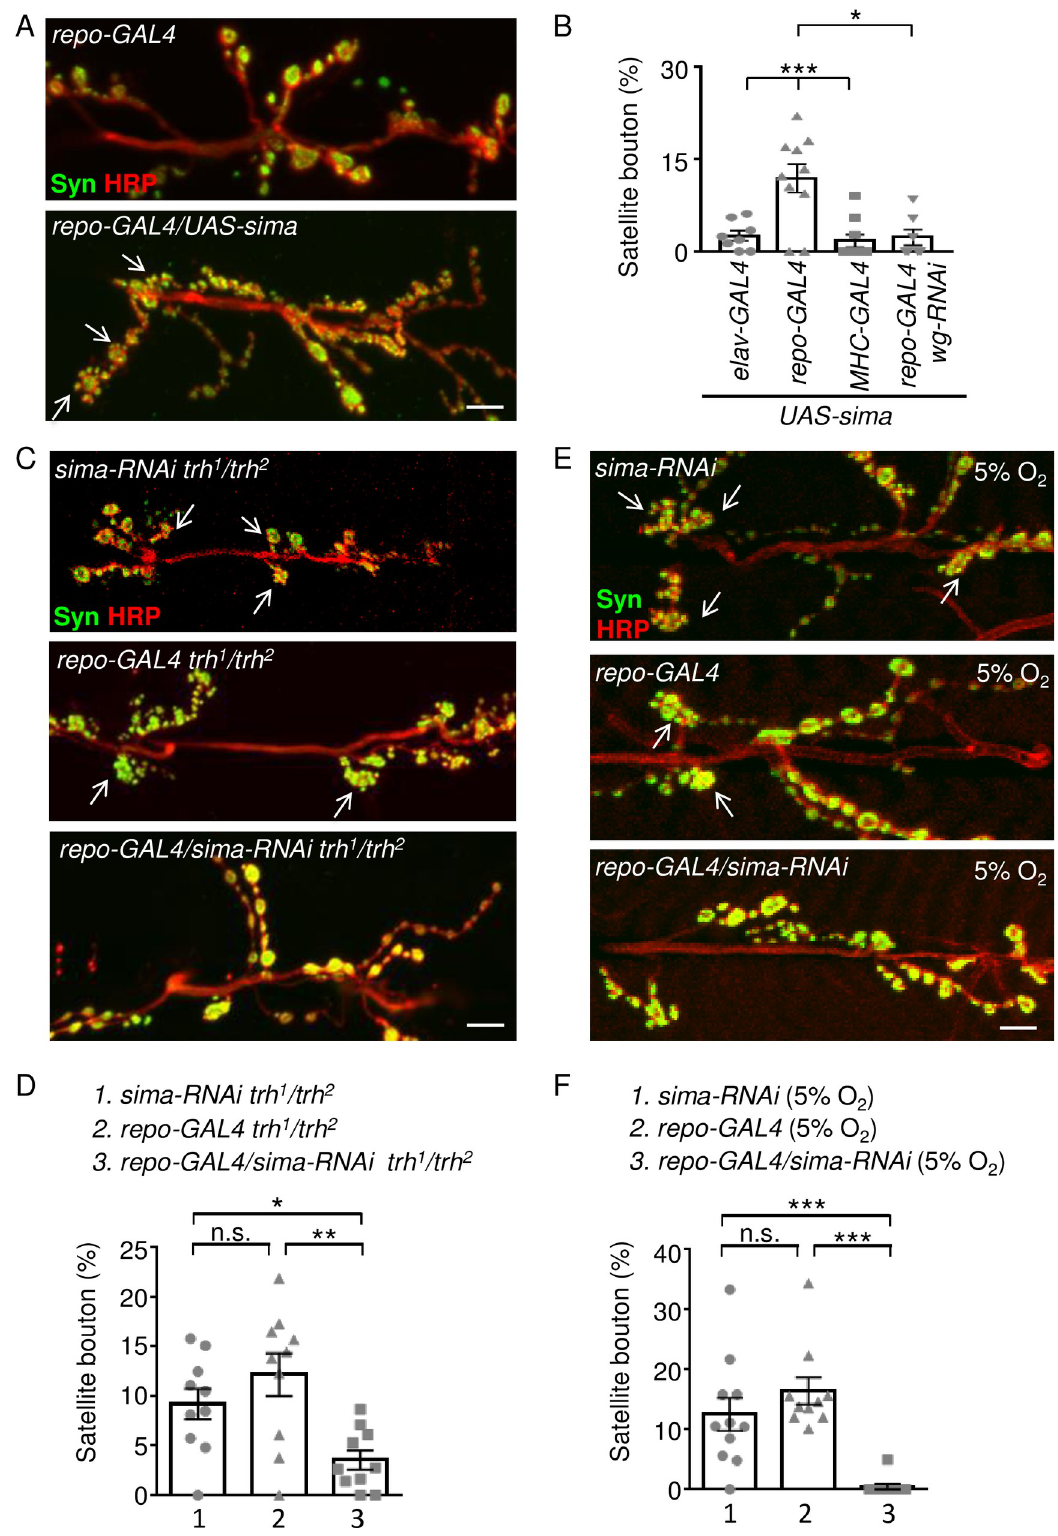
Fig 3. Satellite bouton induction by glial Sima in the trh mutant. (A, C, E) Images showing NMJs from muscle 6/7 immunostained for Syn (green) and HRP (red) in repo-GAL4 , and repo-GAL4/UAS-sima (A), sima-RNAi trh 1 /trh 2 , repo-GAL4 trh 1